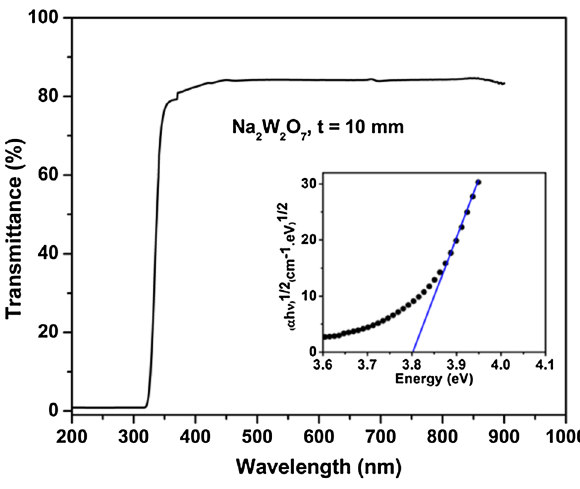
Fig. 3 Transmittance spectrum of a NWO crystal with thickness of 10 mm. Inset figure shows the energy band gap calculation of the crystal